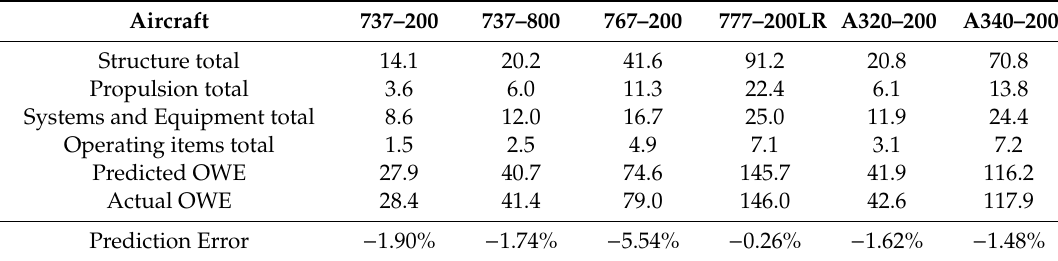
Table 1. Weight estimation tool